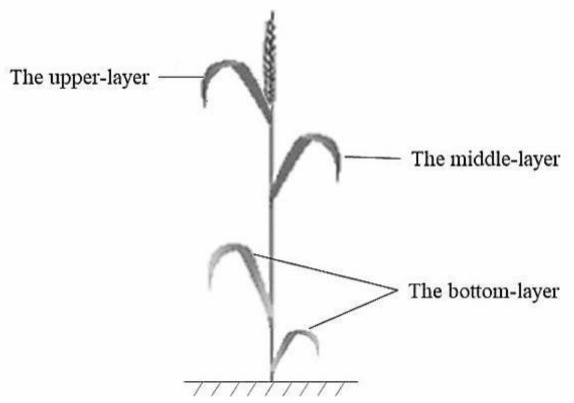
Figure 2. The schematic diagram of vertical division of leaves within wheat canopy. For each subplot, leaves belonging to the same vertical layer were cut from the stems and weighed immediately to obtain the fresh weight ( FW ) using analytical balance.